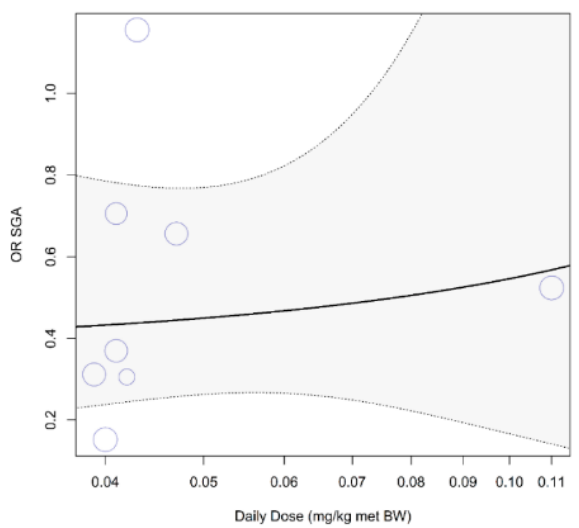
Figure A8. Dose-response curve on prenatal supplementation of arginine on development of small for gestational age (SGA). The available data points do not show a dose-response relation between odd ratio (OR) of development of SGA and daily arginine dose ( p slope = 0.73) in human risk population. Almost all studies clustered at the lower end of the dose spectrum.